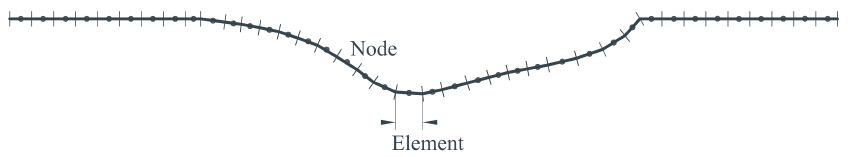
Figure 3. Boundary element method (BEM) discretization by constant